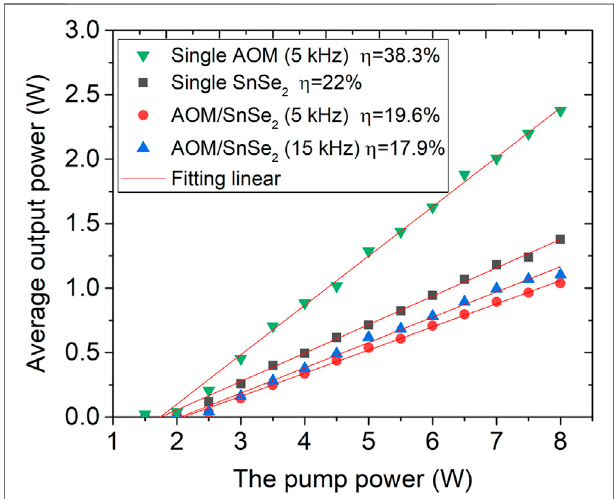
FIGURE 4 | Dependence of the average output power on the pump power for AOM singly, SnSe 2 singly and AOM/SnSe 2 doubly Q-switched lasers with different f A